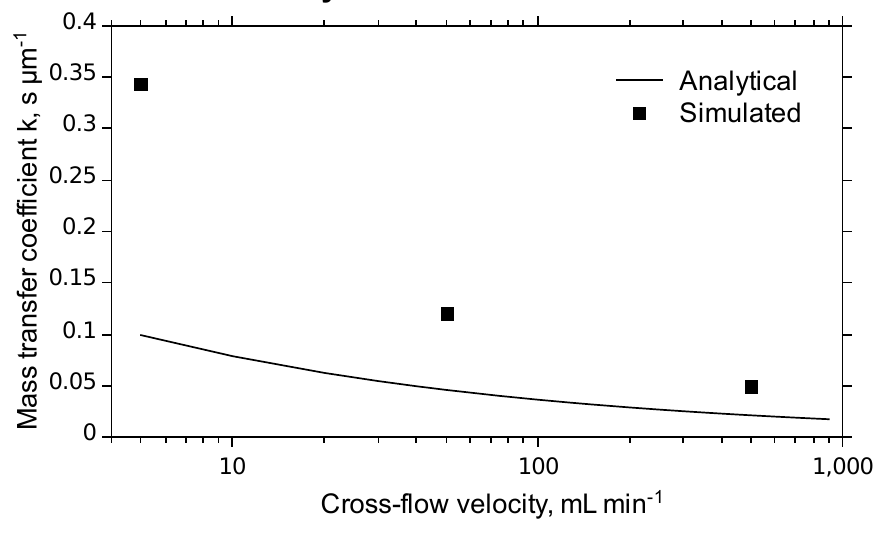
Figure 4. Comparison of k values in chamber A obtained with an analytical model and with d the present CFD model at different cross-flow velocities. Calculations were made with 1 M draw solutions and pure water feed